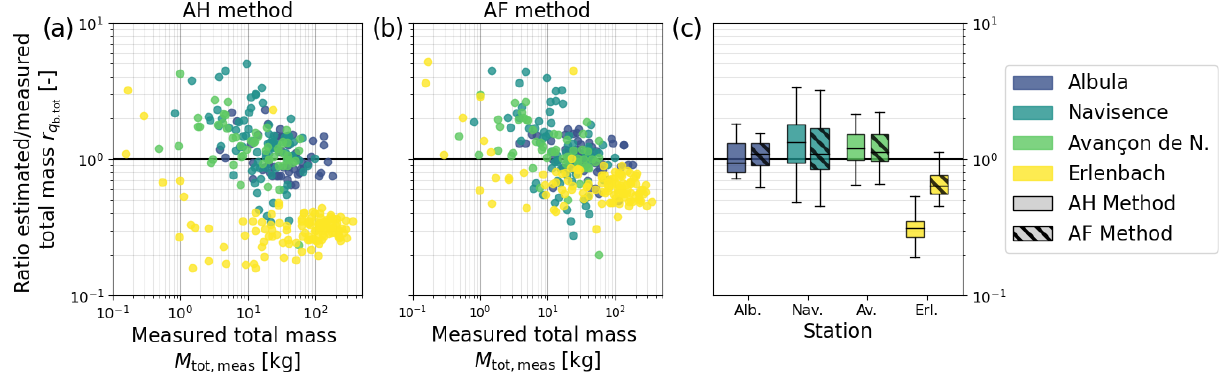
between the estimated and measured unit total mass flux as a function of the total sampled mass M tot , meas for each Figure 10. Ratio r q b , tot collected sample i and each station with the AH method (a) and the AF method (b) . The box plots on the right (c) indicate the range of r q values obtained for each station. The boxes in solid colors show the results obtained with the AH method, and the hatched boxes show the results obtained with the AF method.